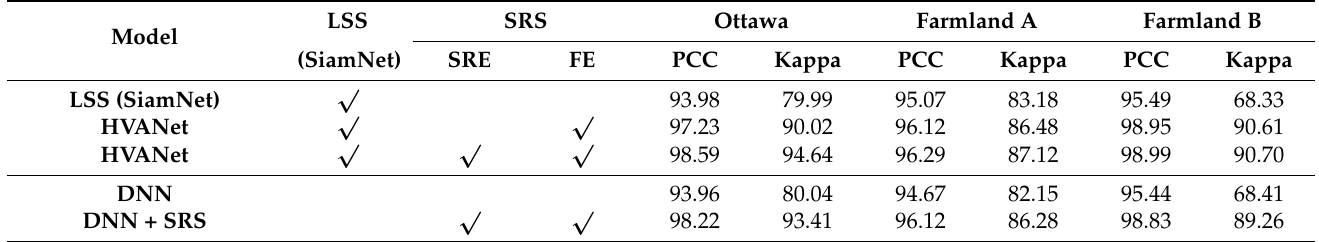
Table 3. Ablation study results of the proposed HVANet on